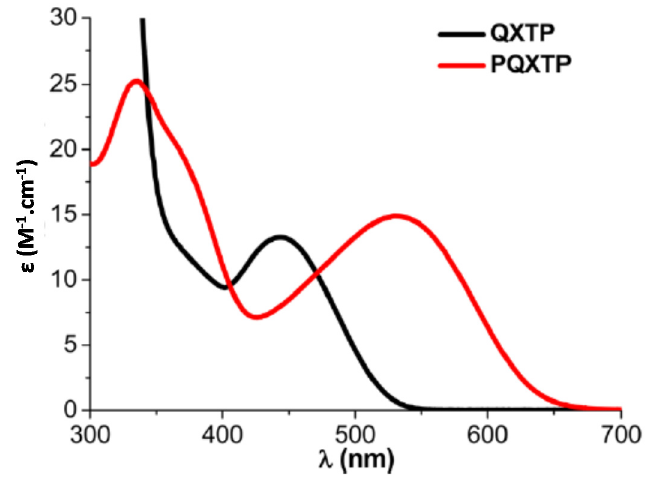
Figure 25. UV-visible absorption spectra of QXTP and PQXTP in THF. Reproduced with permission from Ref. [238] , Copyright 2013 American Chemical Society. Table 9. Monomer conversions obtained during the CP of EPOX using the three-component